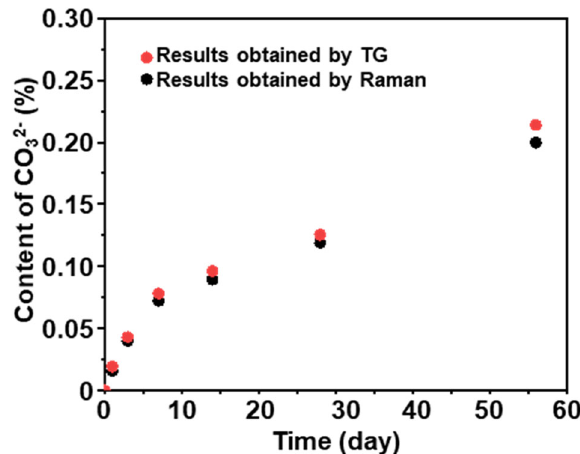
Fig. 6 Comparison between the results obtained by TG and Raman measurements. Plot of the content of CO 32 − obtained by Raman and TG